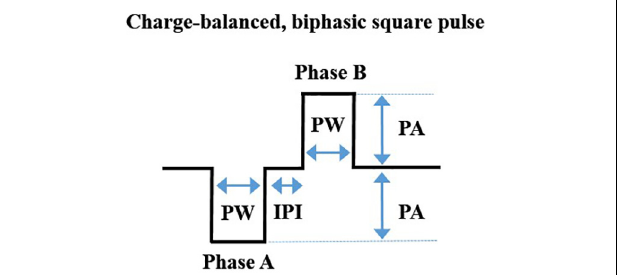
FIGURE 3 | A depiction of the waveform of one charge-balanced, biphasic, cathodic-leading square pulse cycle, showing pulse width (PW), inter-phase interval (IPI), and pulse amplitude (PA). These components have been explained in detail elsewhere (Merrill et al., 2005). Image adapted